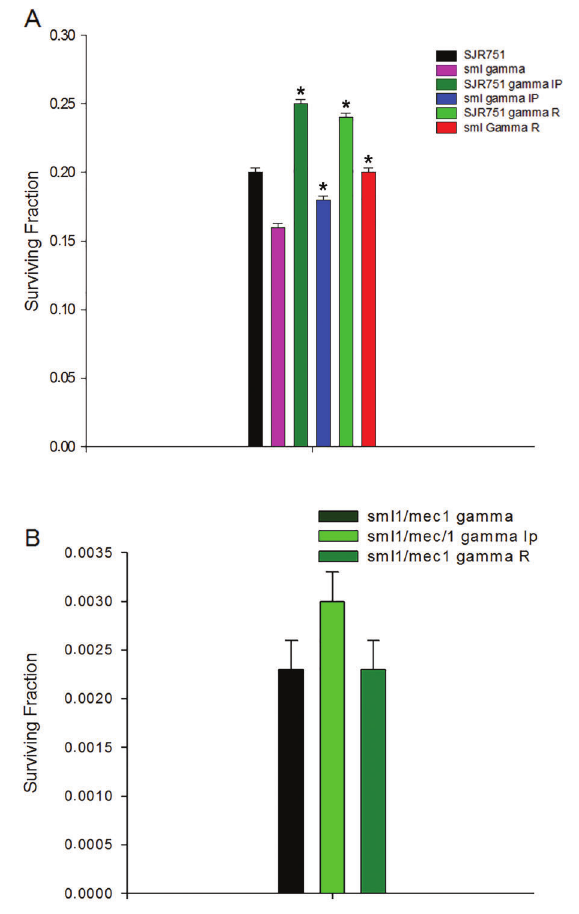
Figure 3. Surviving fractions of wild type SJR751 , sml1 , and sml1/mec1 cell samples exposed to gamma rays (200 Gy), or to indicated combinations. Ip: Ilex paraguariensis ; R: rutin. Data from at least three reproducible experiments are reported as means ± SD. *P o 0.05 (binomial distribution).